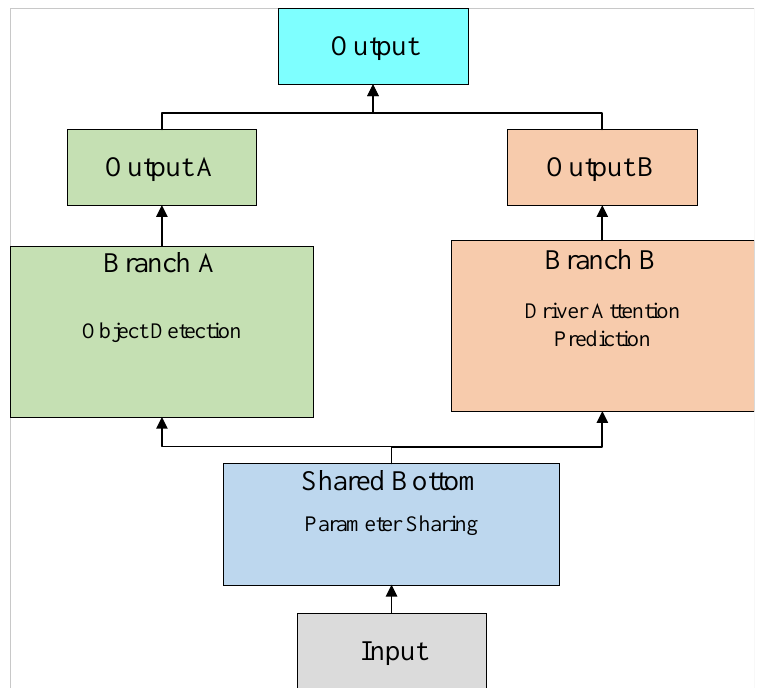
Figure 2. The overall architecture of the proposed SOE network. Input is the captured image from the onboard camera. Shared bottom refers to the 2D CNNs located at the base of the SOE network. Branches A and B represent the domain-adaptive portions of the object detection and DAP tasks, respectively. Output A refers to the categories and locations of the detected objects, whereas Output B is the predicted attention saliency map. Output is the result of the saliency objectives estimation incorporating attention, categories, and